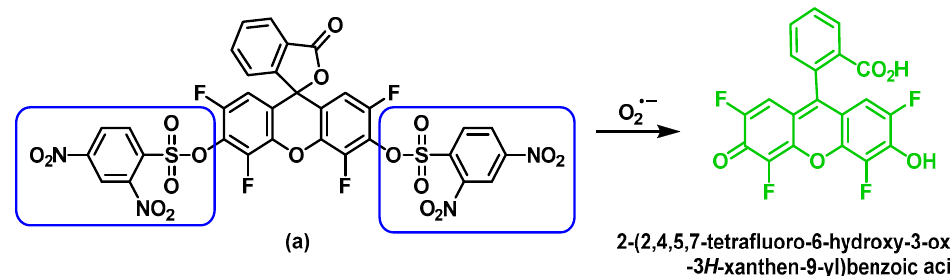
Figure 66. Mechanism of fluorescent response of probe (a) to O 2•– .